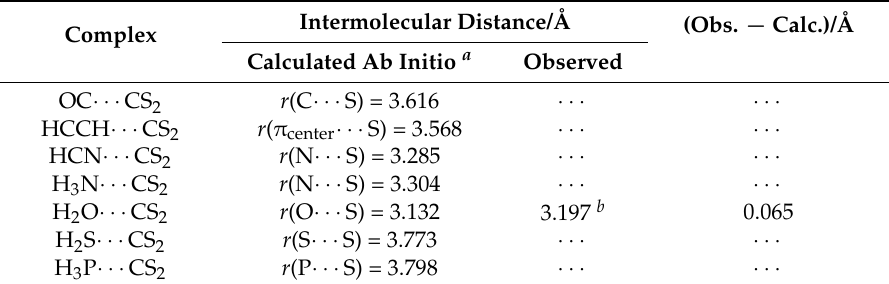
Table 3. Calculated and observed intermolecular distances in B · · · CS 2 complexes.